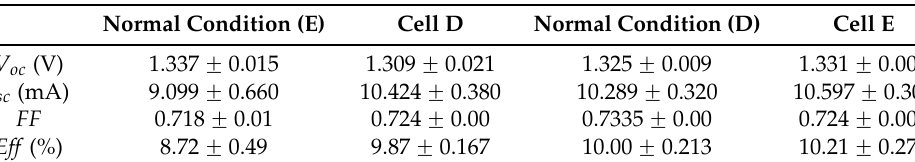
Table 4. Results for each test of cell D and cell E. Each of the values of Eff , V oc , I sc , and FF was averaged for each condition. Normal condition of D is without SEG . Normal condition of E is without SEG . Error bars are standard deviation ( δ ) calculated for each condition.